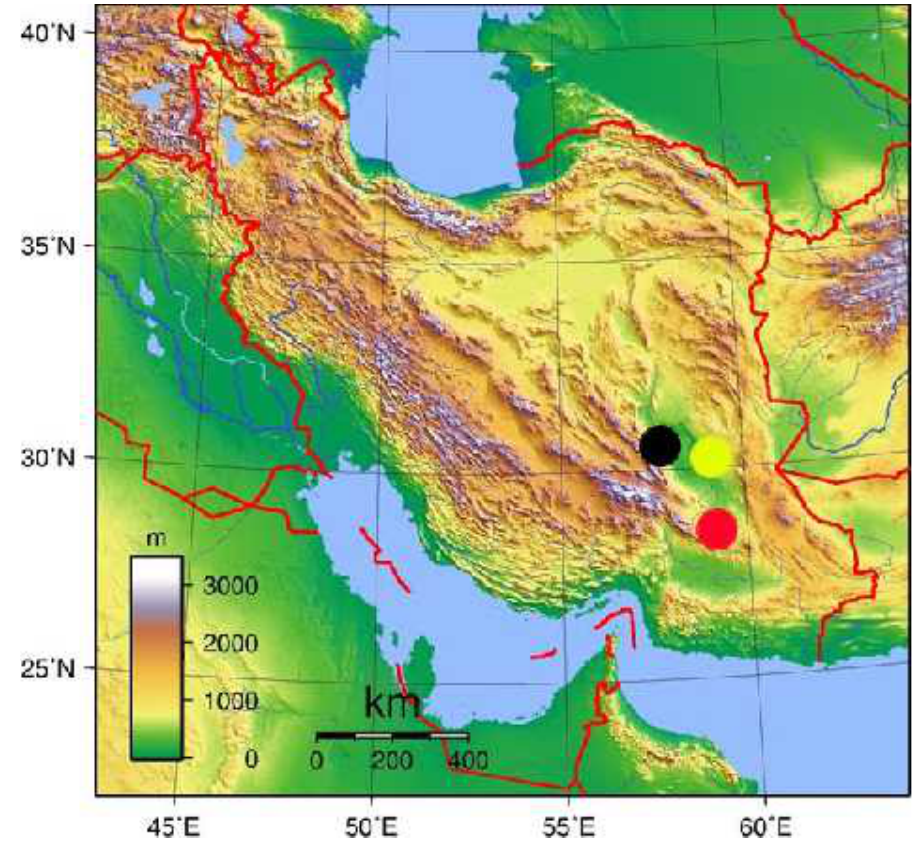
F IGURE . 1. Distribution of Rhinogecko misonnei in Iran. Yellow circle: type locality (Witte, 1973). Black circle: previous record. Red circle: record from present